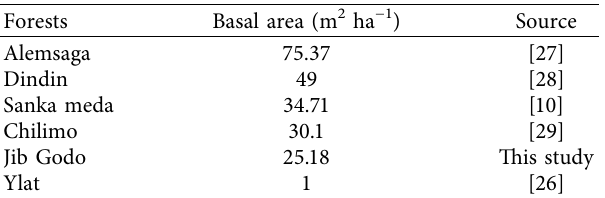
Table 6: Comparison of the BA of Jib Godo Forest with BA of other forests in Ethiopia. Forests